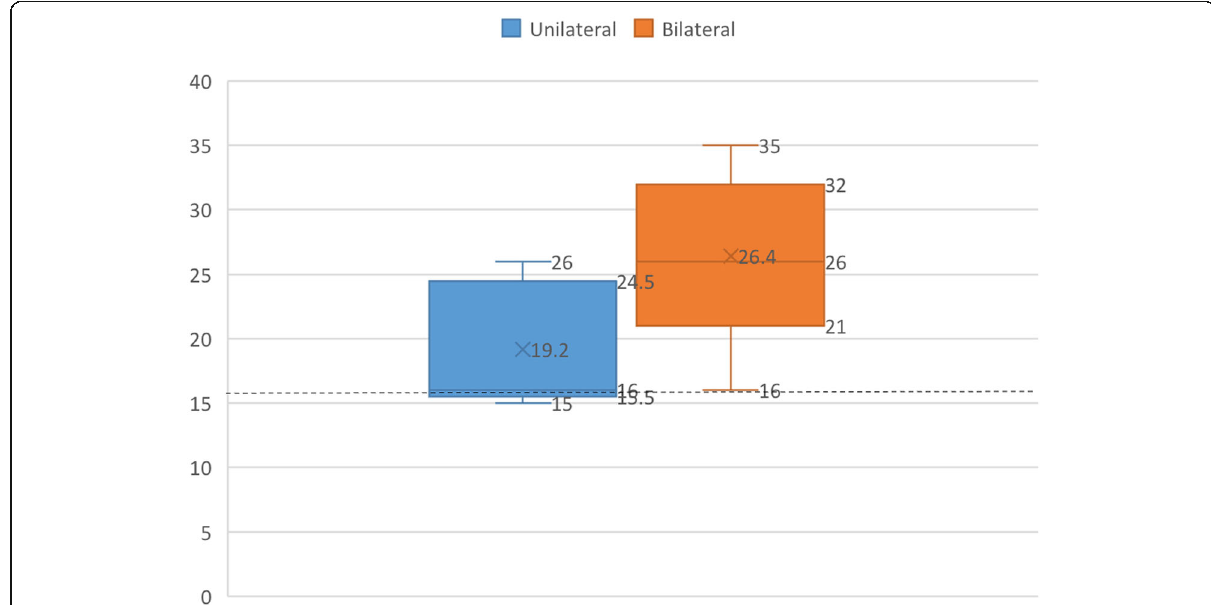
Fig. 7 Box plots of body position processing in children with unilateral and bilateral